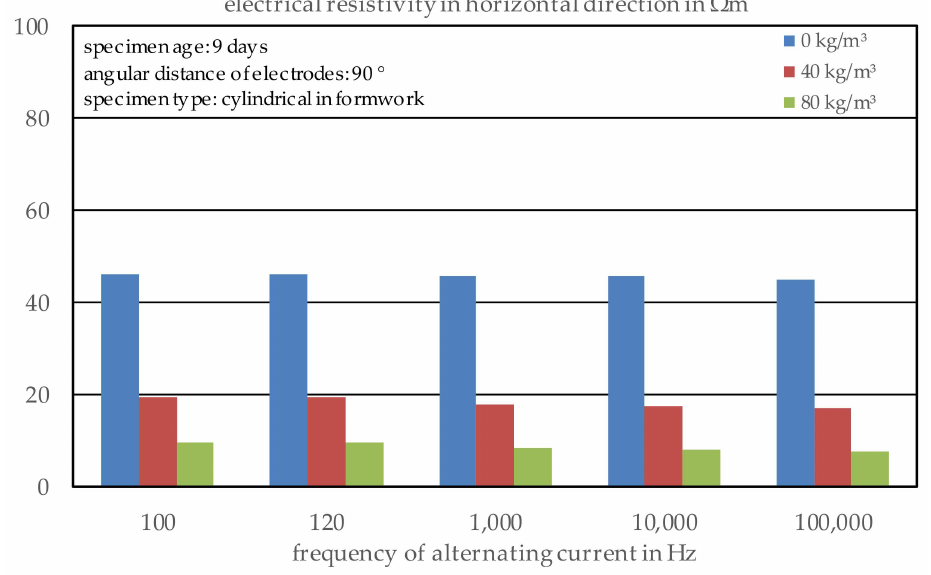
Figure 5. Electrical resistivity in the horizontal direction depending on the frequency and fibre content at a specimen age of 9 days and an electrode array with angular distances of 90 ◦